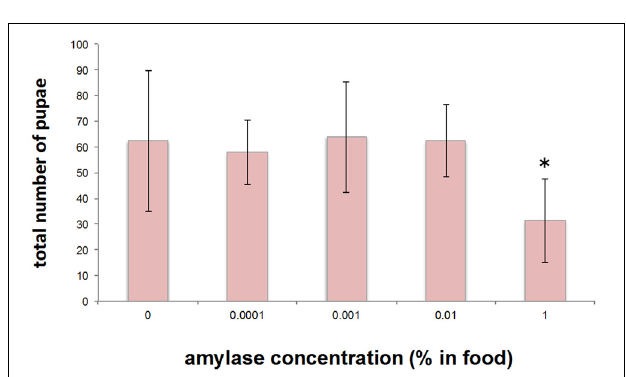
FIGURE 6 | Effect on pupation rate of addition of amylase to the diet. (A) For diets supplemented with 0, 10 − 4 , and 10 − 3 % amylase, pupation peaked at 144h after egg laying. Supplementation of the diet with 10 − 2 or 1% amylase delayed the pupation peak for 24h. The pupation peak occurred later as more amylase was added to the food. (B) At 144h after egg laying, a significant difference was detected between the 0 and 1% amylase-supplemented groups ( p < 0 . 01), and between the 0 and 10 − 2 % amylase-supplemented groups ( p < 0 . 05). * indicates p < 0 . 05. ∗∗ indicates p < 0 . 01.